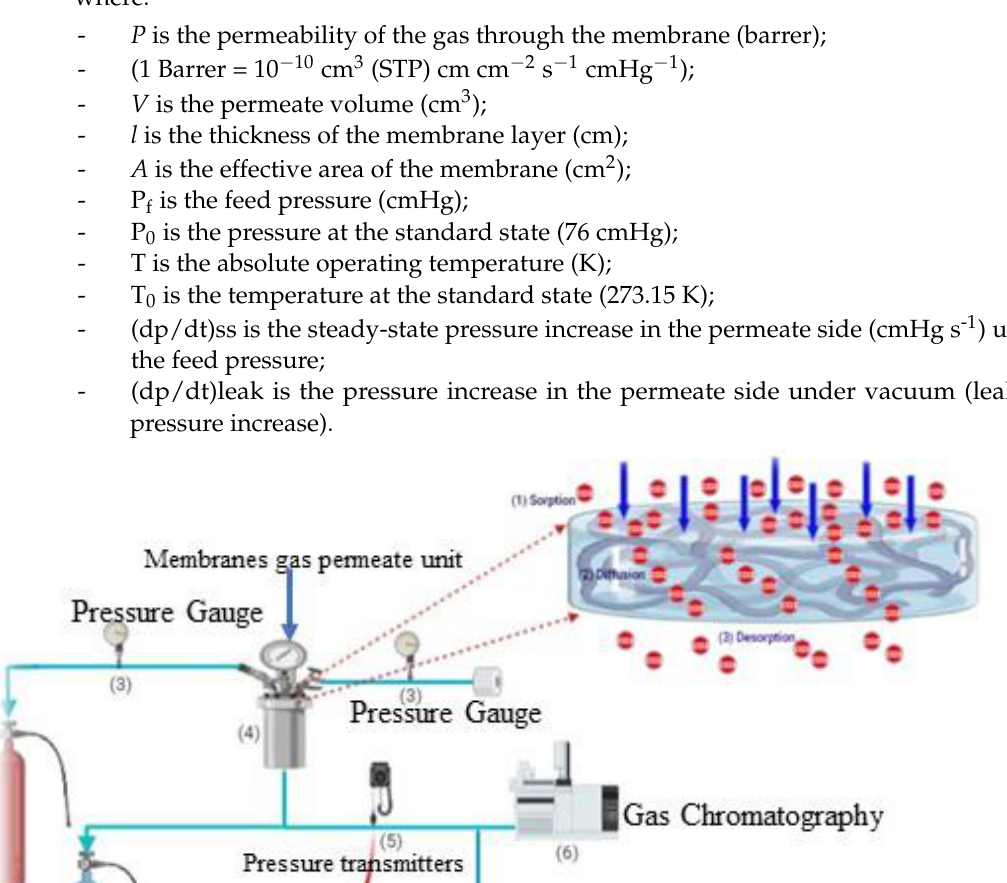
Figure 1. The setup for gas permeation is depicted in this diagram. Gas pairs A and B were calculated to determine their ideal selectivity, α A / B . The ratio of their permeability is defined as follows: